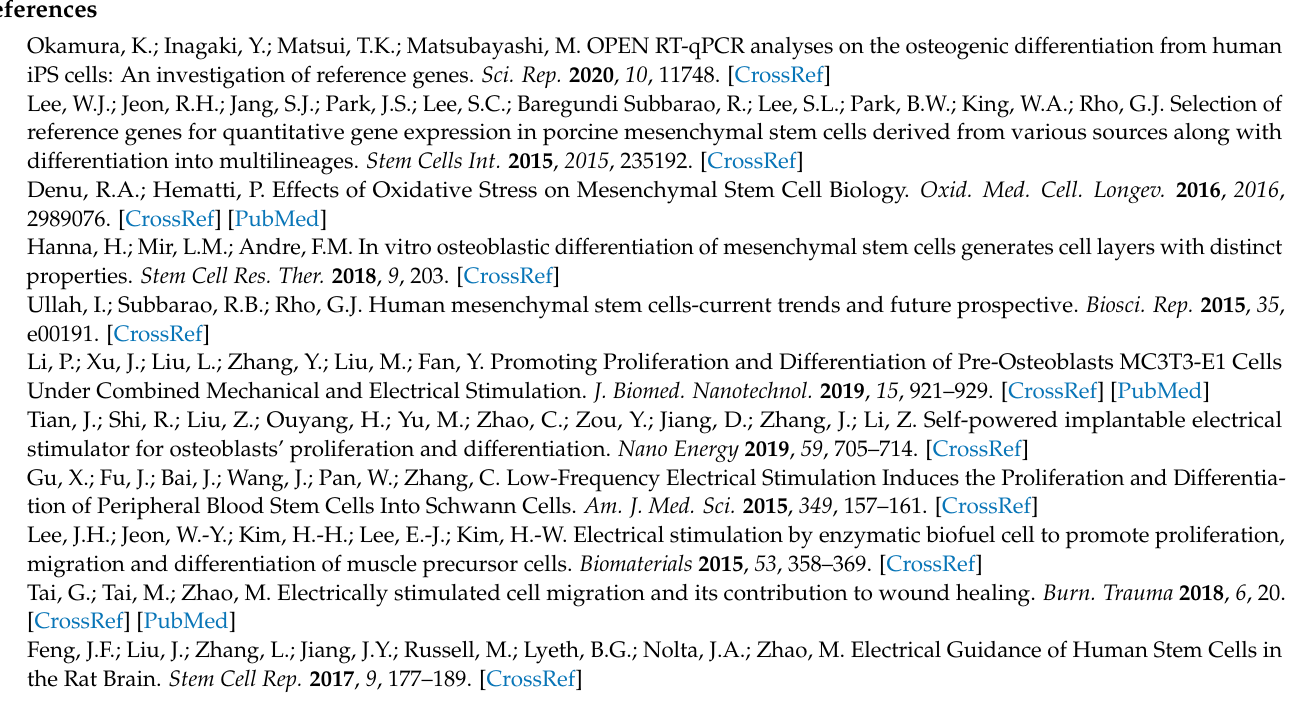
study. Table S2: BestKeeper descriptive statistics for each reference gene in the 5000 cells/cm 2 group. Table S3: BestKeeper descriptive statistics for each reference gene in the 10,000 cells/cmcm 2